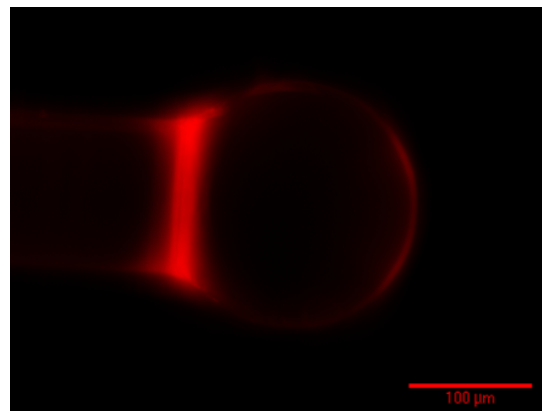
Figure 11. Representative fluorescence microscopy image of the microsphere functionalized by PEG-biotin:PEG from a ratio of 1:1. The functionalization process resulted in a uniform and smooth coverage on the